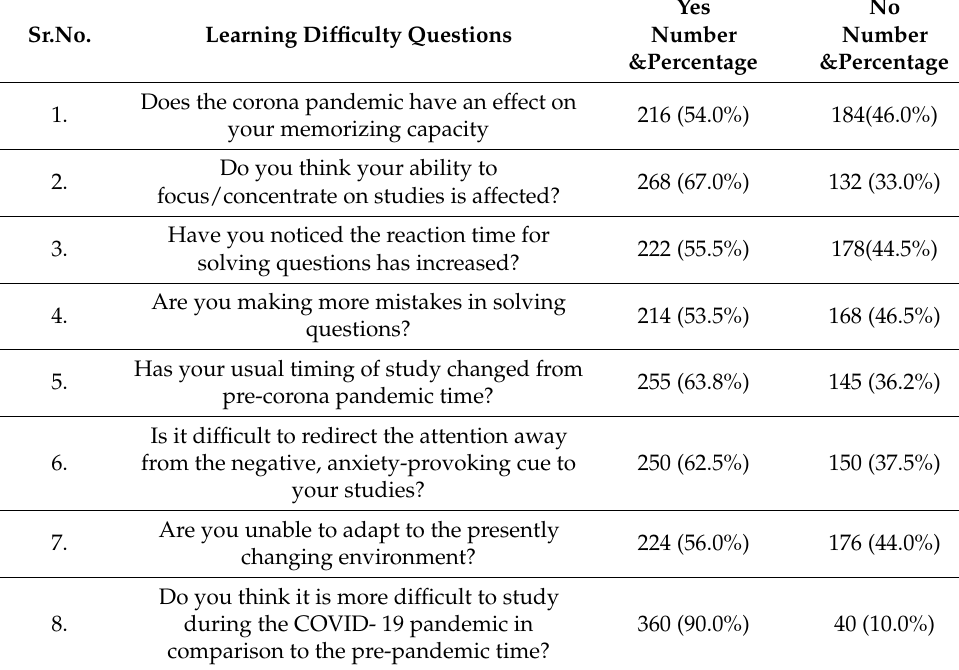
Table 5. Prevalence of learning difficulties as perceived by the students.